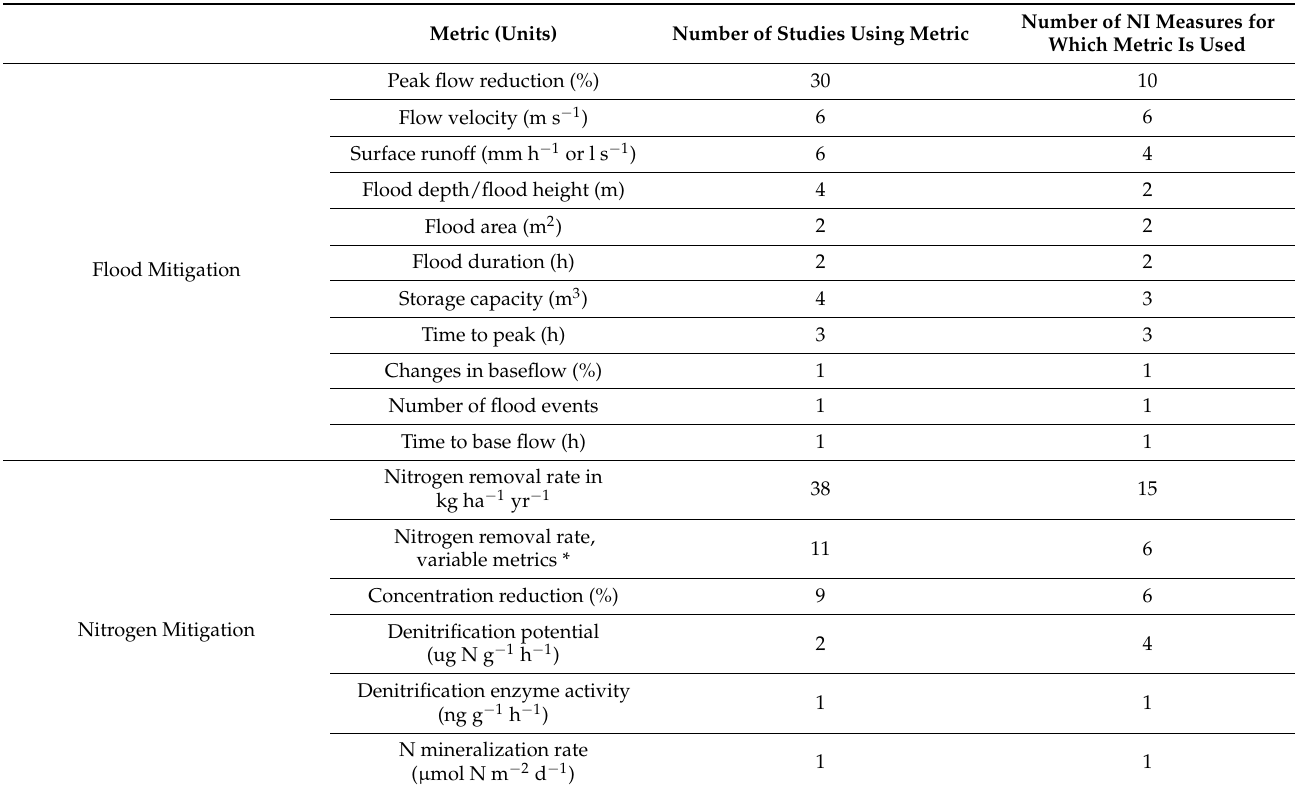
Table 1. Metrics used for natural infrastructure measures in the reviewed literature. Metric (Units) Number of Studies Using Metric